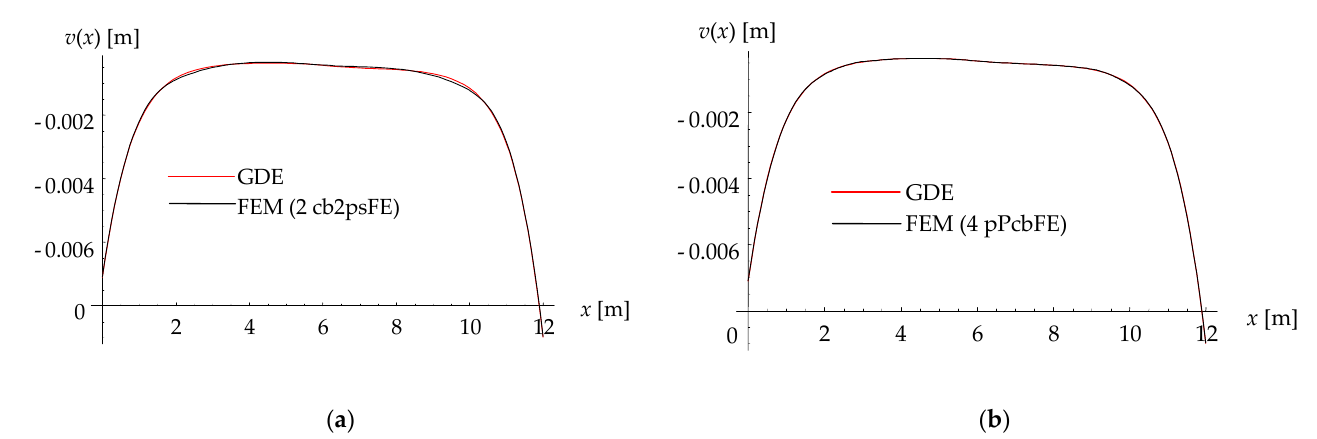
Figure 6. Comparison of transverse displacements for two ( a ) and four ( b ) FE meshes, respectively.